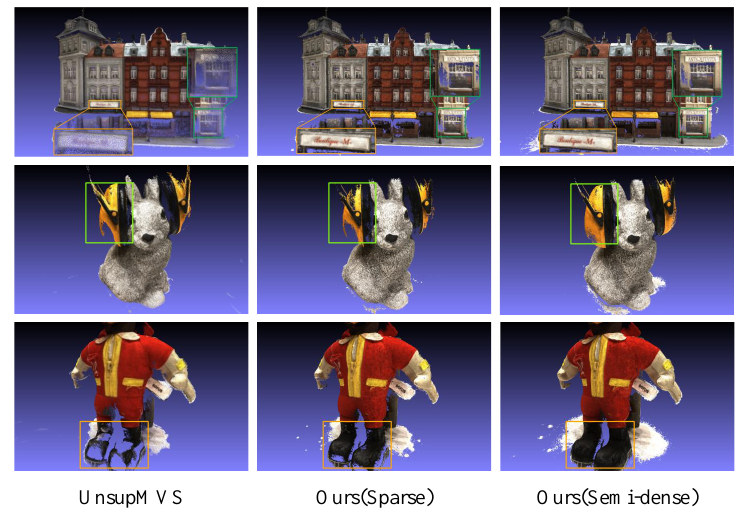
Figure 11. Quantitative results of point cloud reconstruction on the DTU dataset.